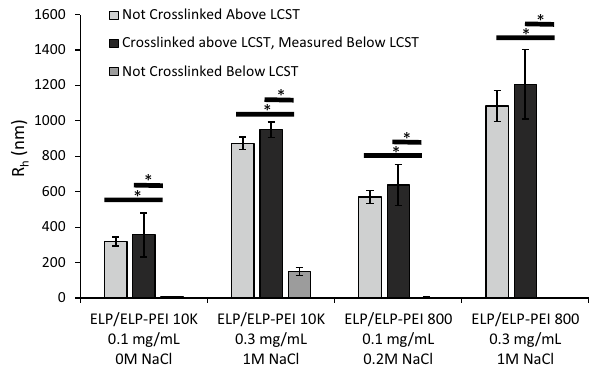
Figure 4. When heated above the LCST, the ELP/ELP-PEI polymers form aggregates that remain present in solution so long as the temperature is maintained (light grey bars). Upon crosslinking, the aggregates remain stable below their LCST at 20 °C (black bars), while the aggregates of the non-crosslinked polymers dissolve in the solution below their LCST at 20 °C (dark grey